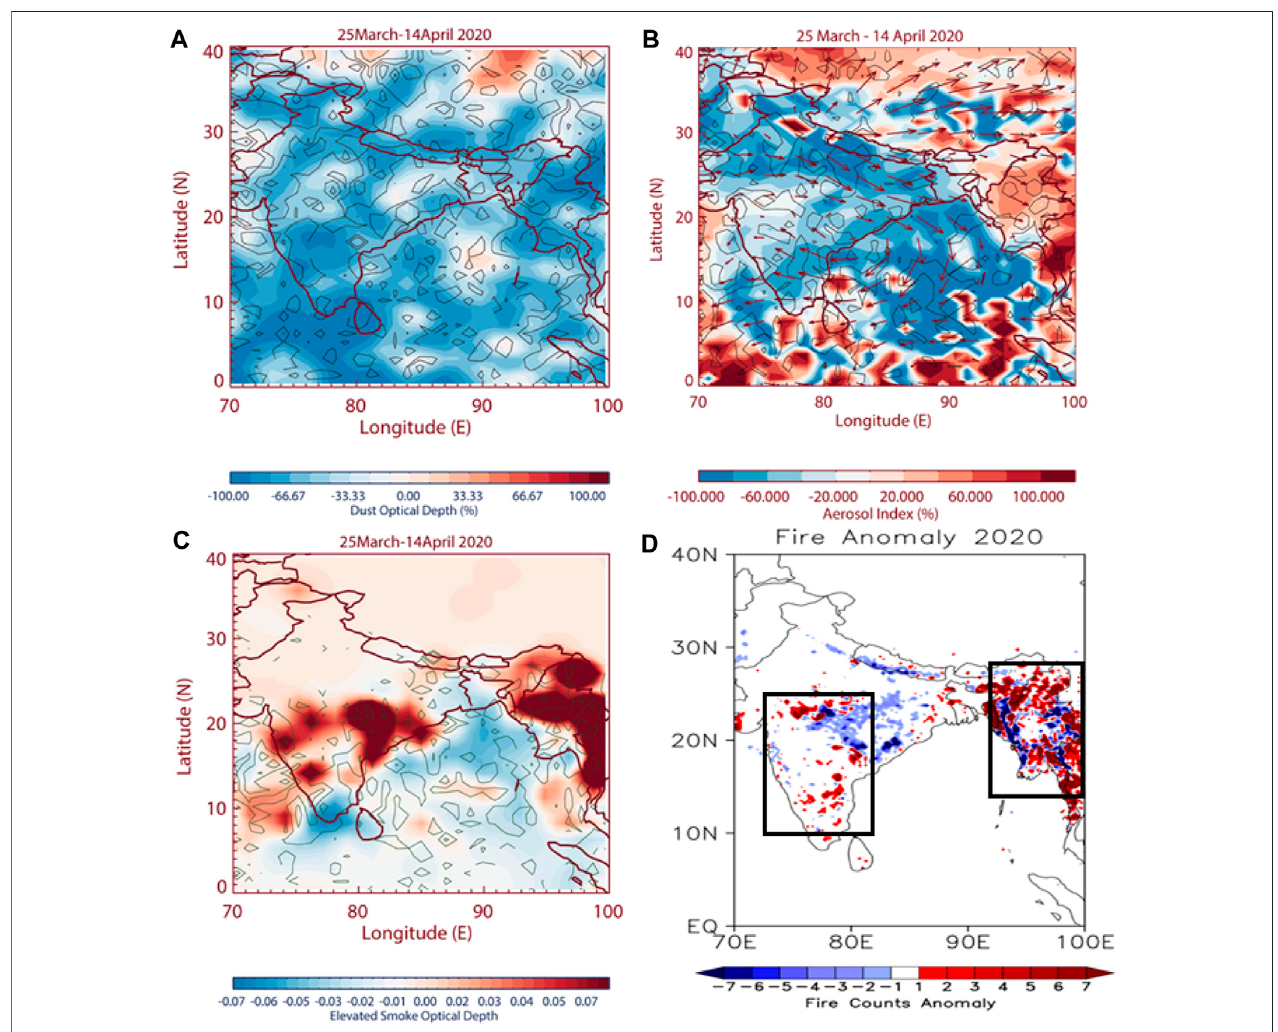
FIGURE 2 | (A) Spatial distribution of changes in dust optical depth (%) from CALIPSO at 532 nm, (B) spatial distribution of changes in OMI aerosol index (%), (C) same as (A) but for CALIPSO elevated smoke optical depth at 532 nm, (D) changes in fi re counts distribution (2020-climatology) from MODIS. All the datasets are from thelockdownperiodMarch25toApril14.ContoursinPanels (A – C) indicatea95%signi fi cancelevel.Boxes(10 ° N – 25 ° N;72 ° E – 81 ° E)inPanel (D) indicatethelocationof large numbers of fi re anomalies.